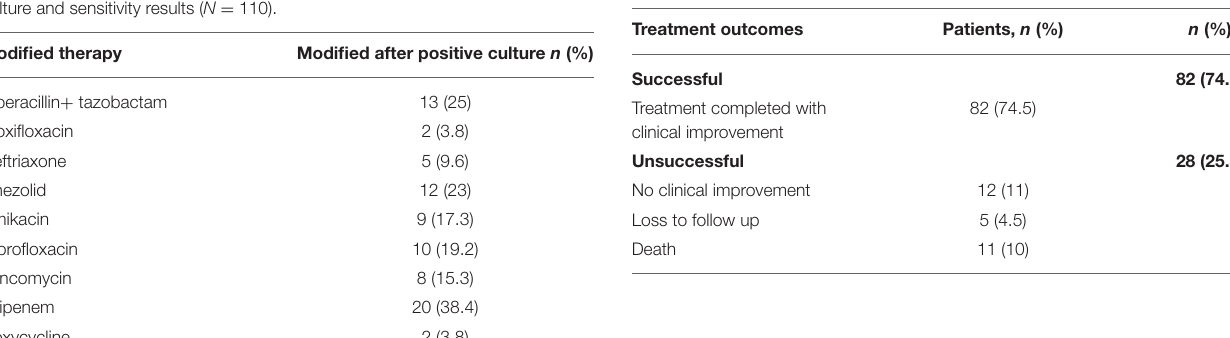
TABLE 5 | Treatment outcomes among the empyema thoracis patients ( N =